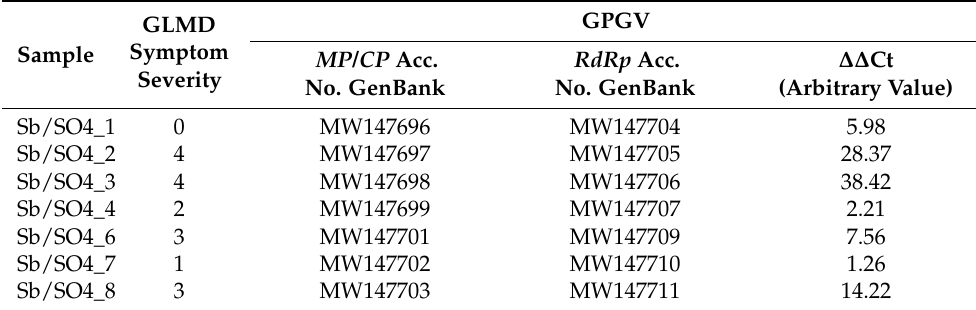
Table 1. Sampled grapevines GLMD symptom severity, Acc. Nos. of obtained GPGV sequences in GenBank/NCBI and relative quantities ( ∆∆ Ct) of GPGV in plant samples. GLMD symptom severity: 0—no symptoms, 1—curly top leaves, 2—curly top leaves, deformation of the leaves and stunted growth, 3—curly top leaves, deformation of the leaves, stunted growth, and thin internodes, 4—curly top leaves, deformation of the leaves, stunted growth, thin internodes, and dense